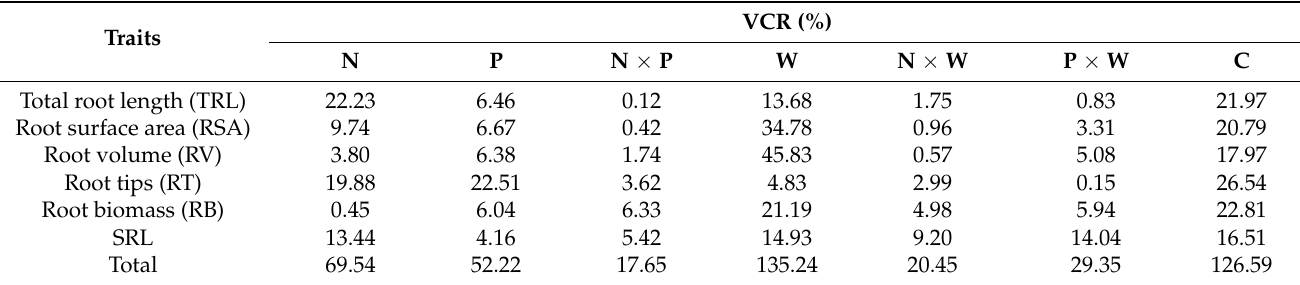
Table 4. Variance contribution rate (VCR) of the effects of nitrogen addition (N), phosphorus addition (P) and water addition (W) and their interactions (N × P, N × W and P × W), in addition to fragment size (C), on six root traits for Stipa breviflora .